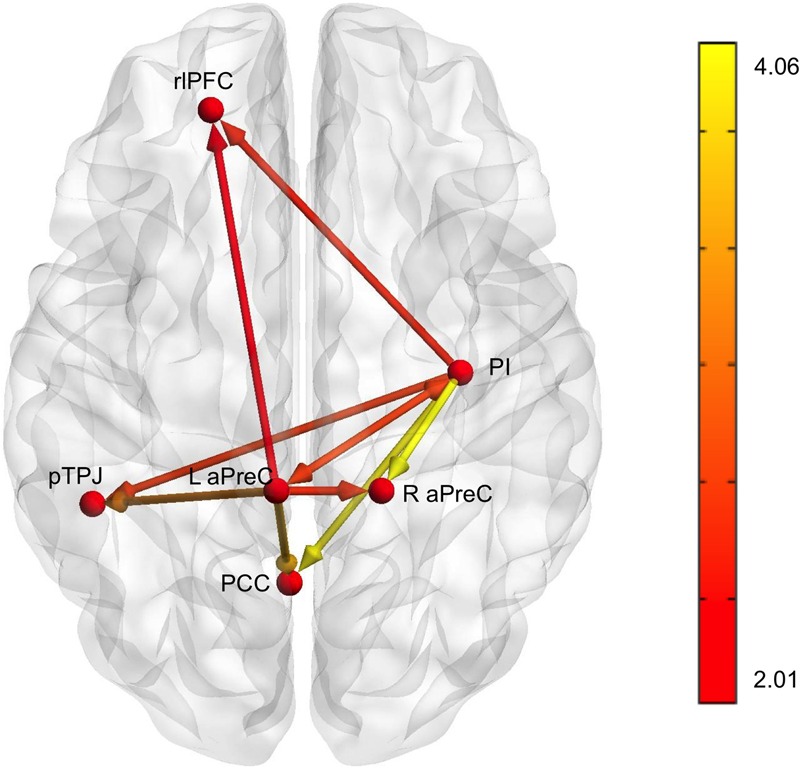
Results for multivariate Granger causality analysis. The effective connectivity network for bad advice during the decision phase for run 1 when comparing the human with machine agent showed that the PI (posterior insula) and L aPreC (anterior precuneus) were drivers of the network and also the source ROIs for all other target ROIs (R aPreC, PCC posterior cingulate cortex), rlPFC (rostrolateral prefontal cortex), and pTPJ (posterior temporoparietal junction). Note that all connections survived q(FDR) < 0.05, except the connections to rlPFC that survived q(FDR) < 0.08. The color bar represents the t-value of the comparisons shown in Table 2.